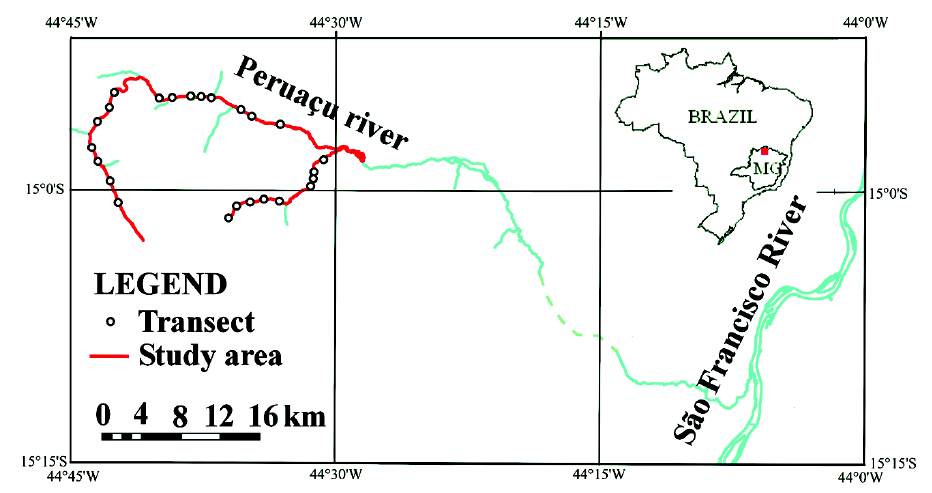
Figure 3. Location of the study